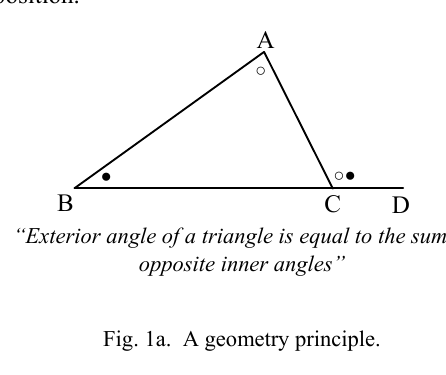
Fig. 1a. A geometry principle.